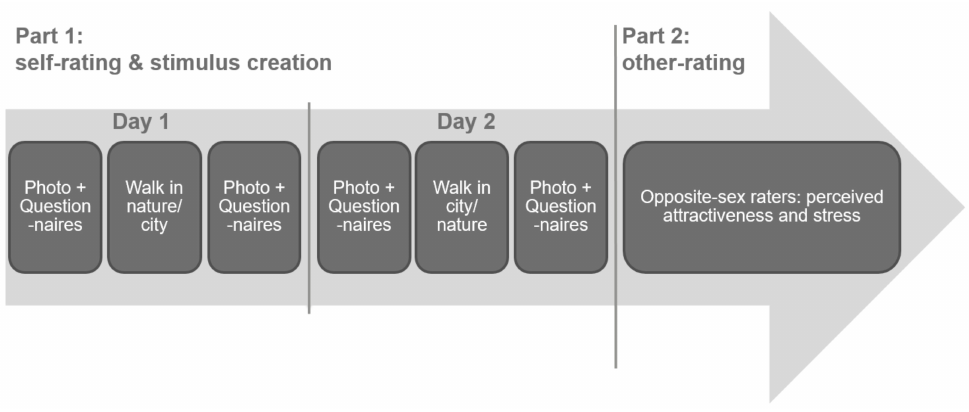
Figure 1. Overview of study design and